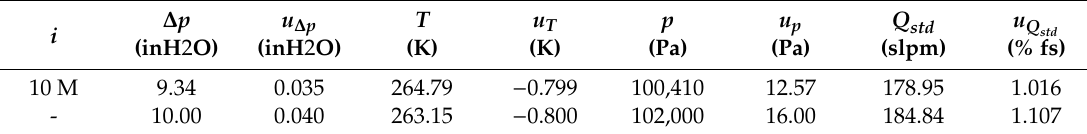
Table 11. Simulation 2: standard volumetric flow rate.